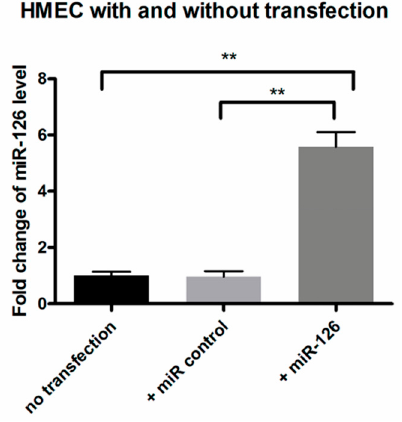
Figure 4. Expression of miR-126 in human microvascular endothelial cell (HMEC) after transfection. miR-126 expression in HMEC without transfection or transfected with either a negative control or miR-126 . Data are expressed as relative fold change of miR-126 ± SD ( n = 4), ** p < 0.01.